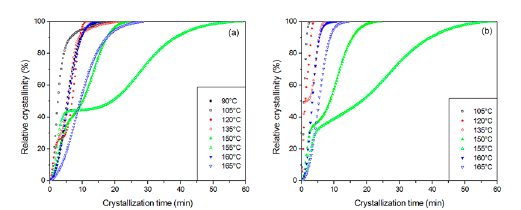
Figure 6. Relative crystallinity vs. time at various crystallization temperatures for (a) scPLA and (b) scPLA/GNPO+ nanocomposite. From Figure 6, two step curves can be seen when T between 120 and 155ºC which is related to the